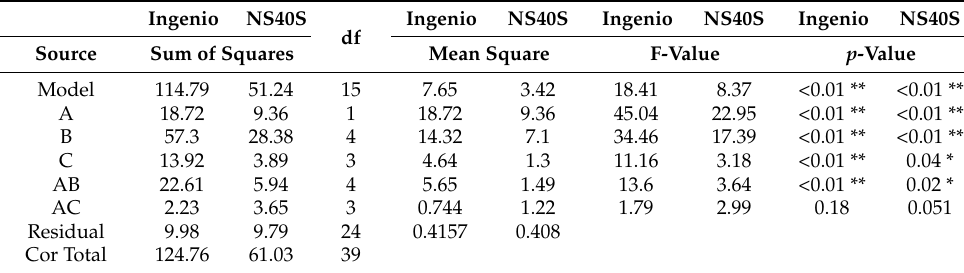
Table 6. ANOVA table for biomass in